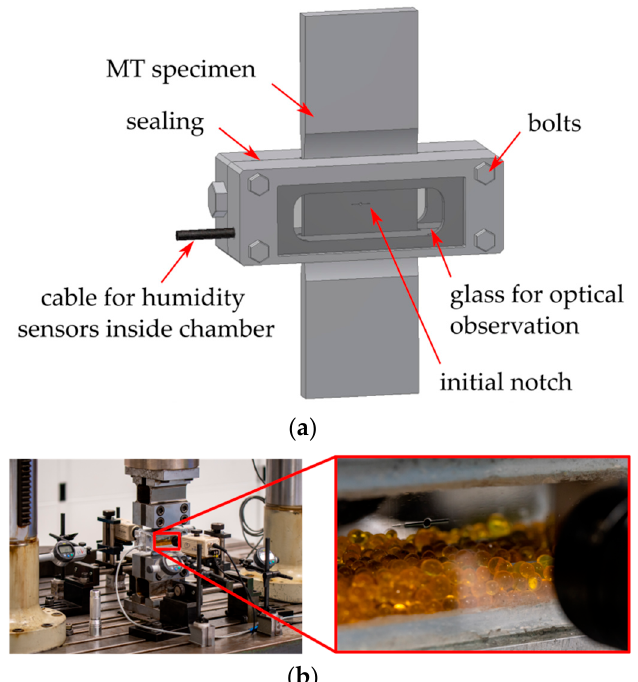
Figure 7. Special test setup for tests in dry air: ( a ) scheme of the sealed chamber and ( b ) image of the experiment showing the crack surrounded by silica gel particles.